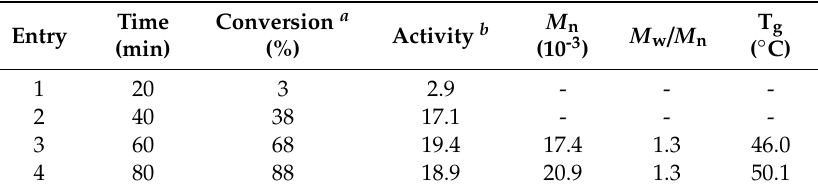
Table 20. Microwave-assisted polymerization of r- lactide catalyzed by 23 [31].